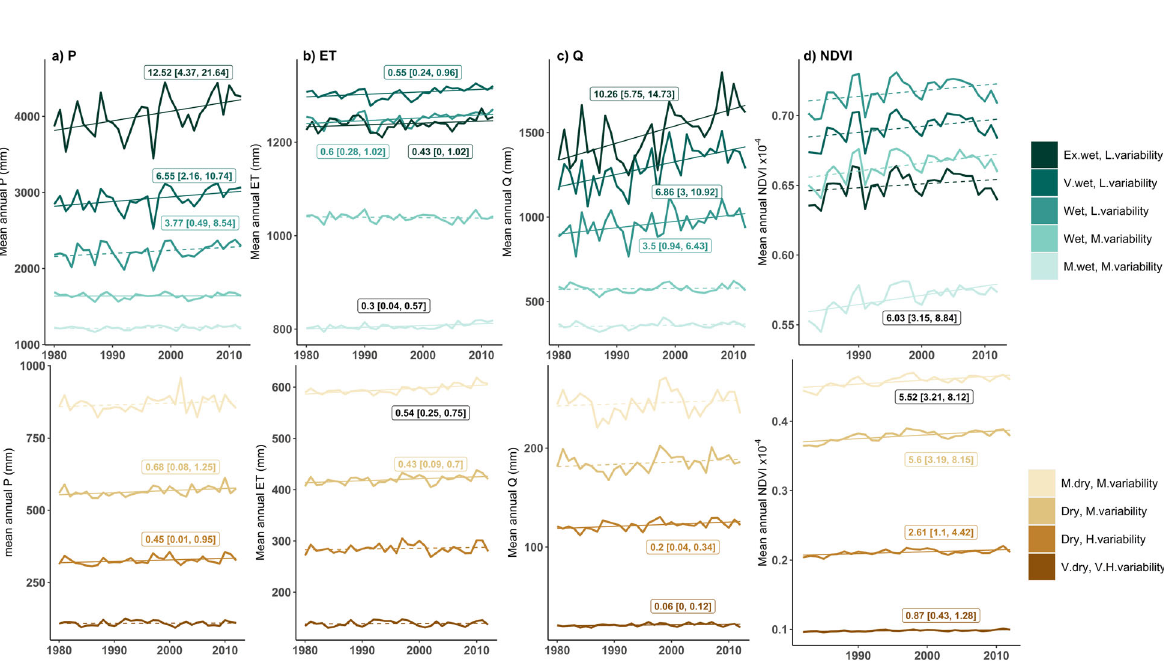
Fig. 2 Global trends in P , ET, Q and NDVI. Time series of annual totals in ( a ) P , ( b ) ET and ( c ) Q in (mm), and ( d ) annual averages of monthly NDVI (unitless × 10 − 4 ) computed for the dry and wet precipitation regimes during 1980 – 2012. Where trends are statistically signi fi cant, trendlines are displayed, and slopes and con fi dence intervals computed using Mann – Kendall and Sen ’ s slope methods are shown. Trends are deemed statistically signi fi cant if the con fi dence interval of the slope is strictly positive or strictly negative. The nine precipitation regimes are labelled from driest (bottom) to wettest (top) as listed in caption for Fig.